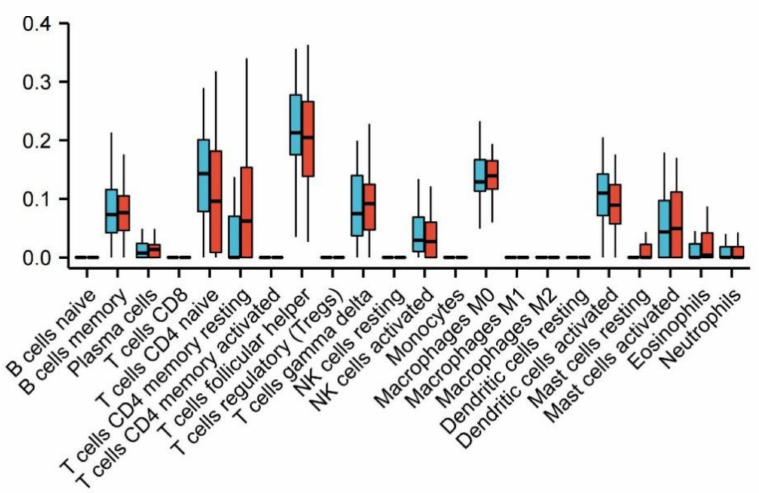
Figure 11. Comparison of immune cells in 22 patients with schizophrenia and healthy people. Blue represents healthy samples and red represents schizophrenic patients.